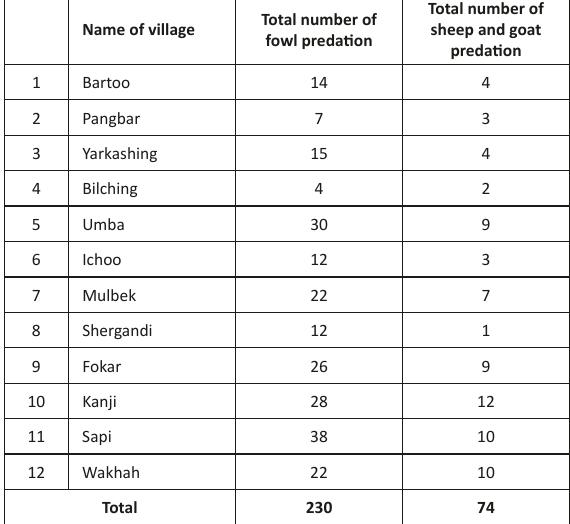
Table 2. Red Fox predation during different time intervals of the day Time interval (hr)